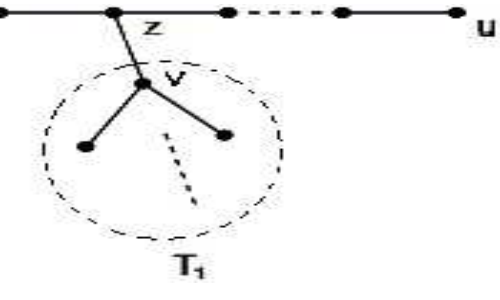
* T Constructed from T n